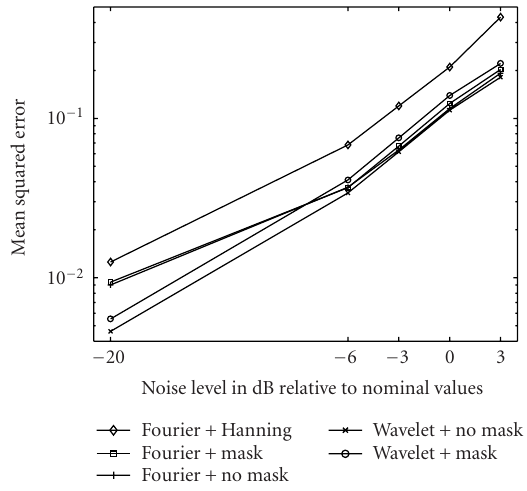
Figure 9: Comparison of the mean squared errors on the estima- tion of the emission law of SZ as a function of noise in five di ff erent configurations: wSMICA without mask, wSMICA with mask, fS- MICA without mask, fSMICA with mask, and fSMICA with Han- ning apodizing